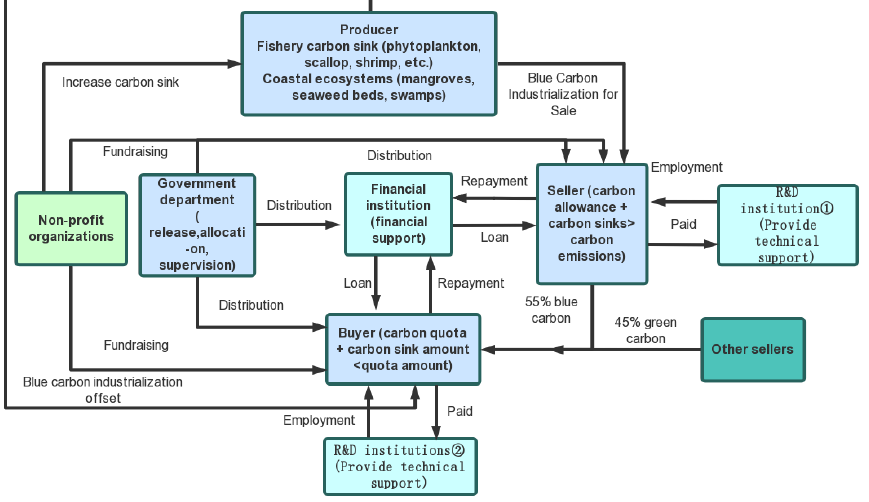
Figure 1. Blue carbon circulation diagram. (Source: Designed by the authors).